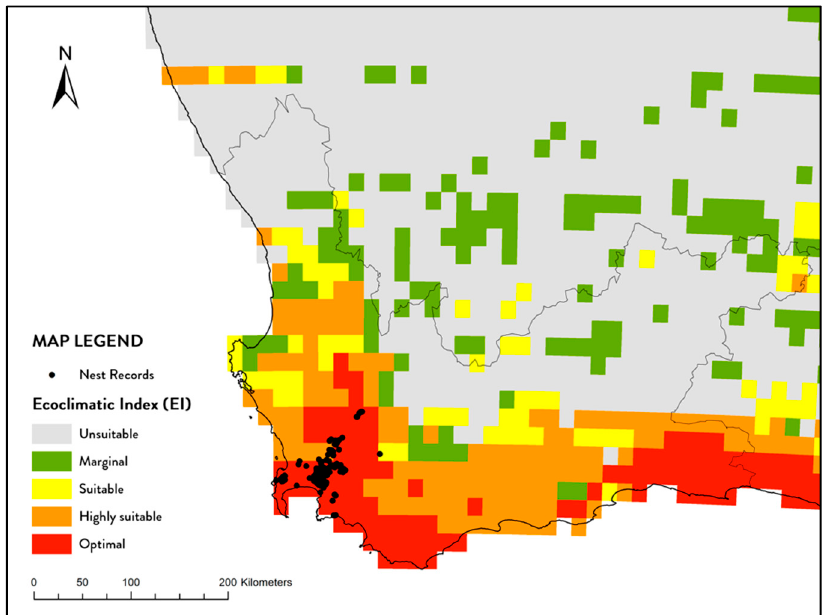
Figure 2. Distribution of V. germanica nests recorded in South Africa (2012 to 2019) and CLIMEX overlay indicating climatic Scheme 10. De Villiers et al., 2017).